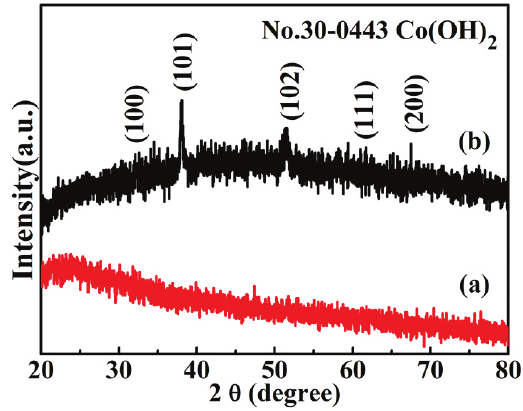
Figure 1. XRD patterns of products with heating time of (a) 6 h and (b) 10